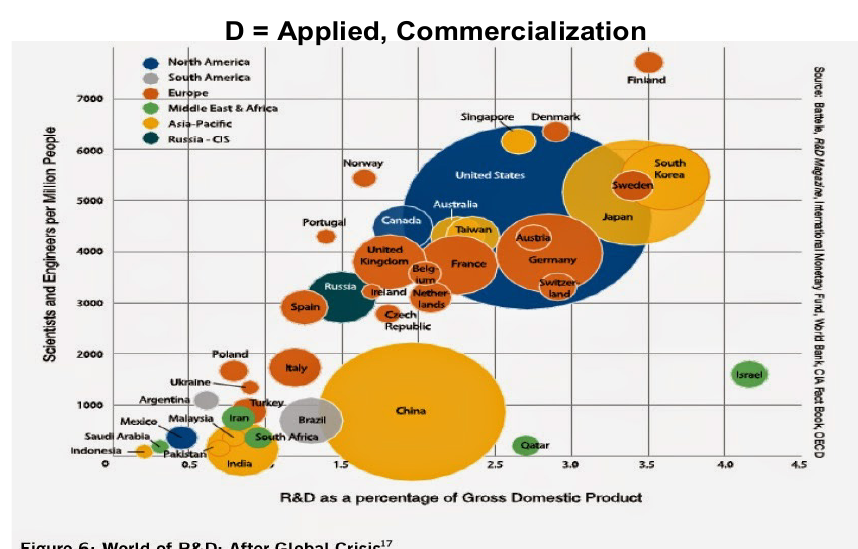
Figure 4. The science-commercialization